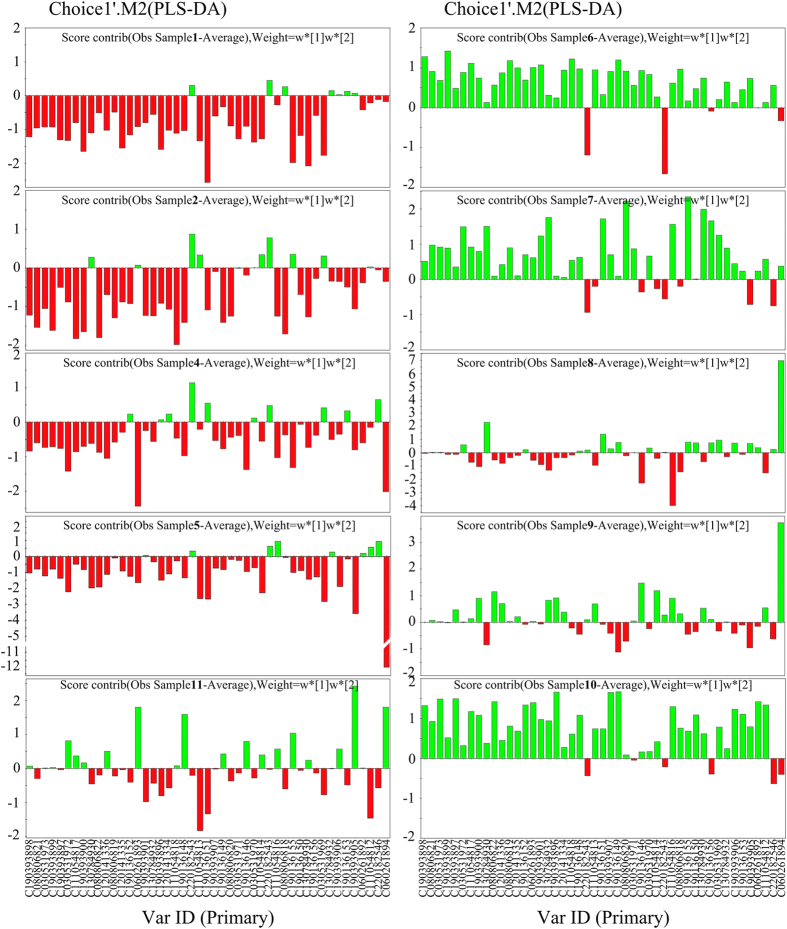
The regression coefficients of the PLS-DA model of the NSTA (sample 1) and the control (sample 6).Positive coefficients (green) indicate relatively higher values for degree of methylation in NSTA compared with the control samples, whereas negative coefficients indicate lower values (red). The magnitude of the coefficient represents the relative importance of each data bit on the separation contribution.